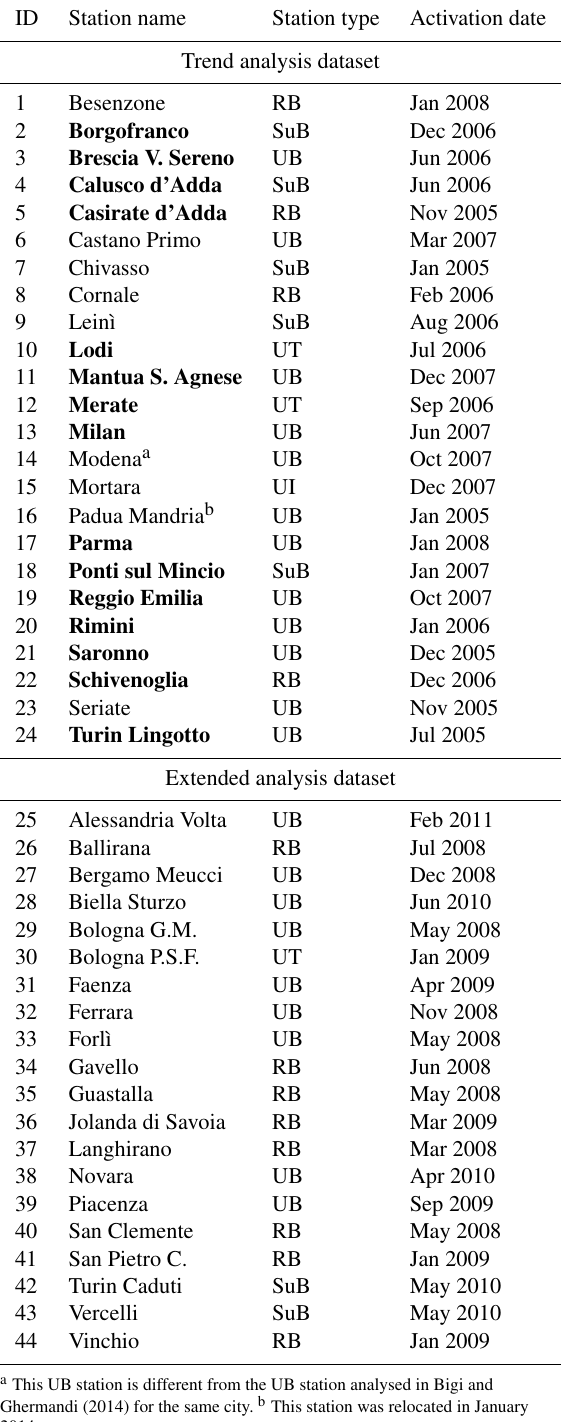
Table 1. Analysed PM 2 . 5 sampling sites for trend and for extended statistical analysis. All sites were active until January 2015. At bold- faced stations also PM 10 data were available. Station types: UT – urban traffic, UI – urban industrial, UB – urban background, SuB – suburban background, and RB – rural